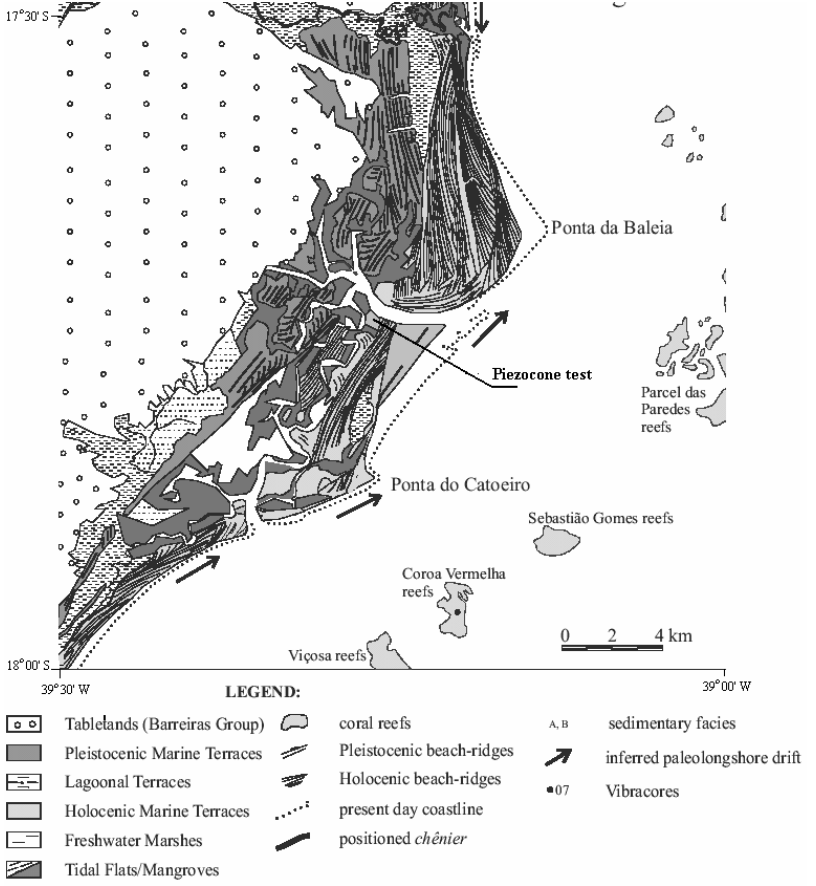
Fig. 4 – Geological setting of Caravelas region, indicating facies distribution and the piezocone test location (Modified from Andrade et al.